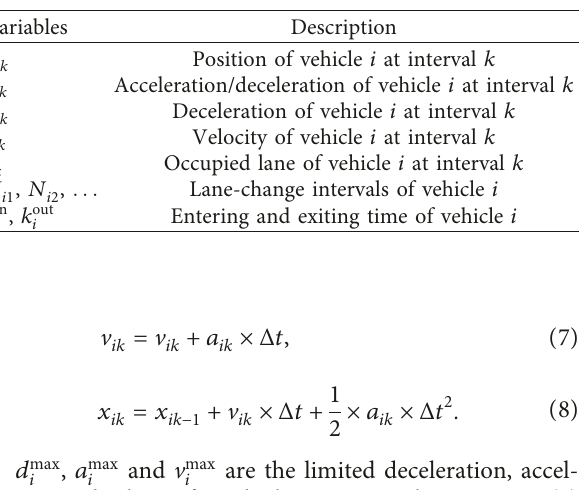
Figure 1: Illustration of vehicle trajectories. Table 1: Description of